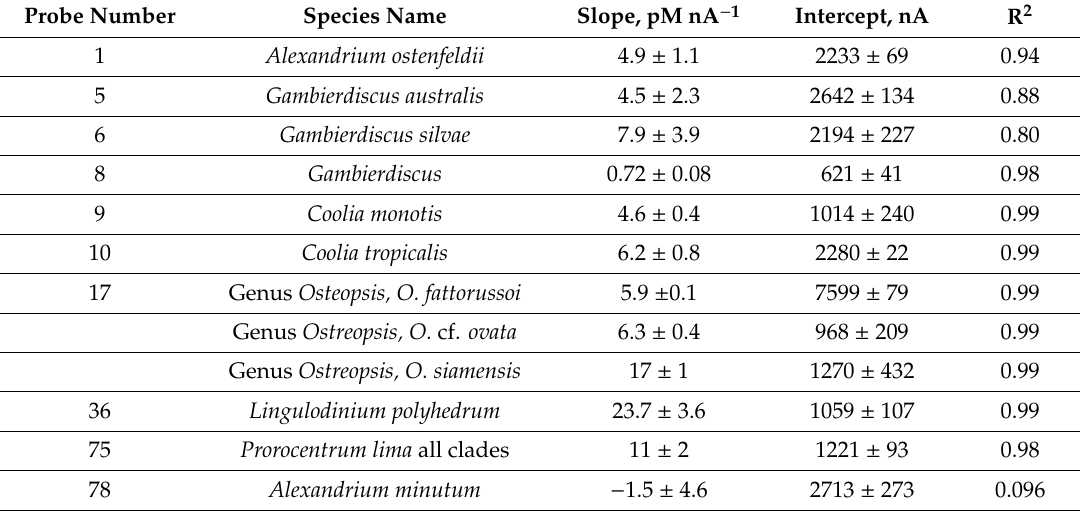
Table 4. Analytical characteristics of the calibration plots displayed in Figure